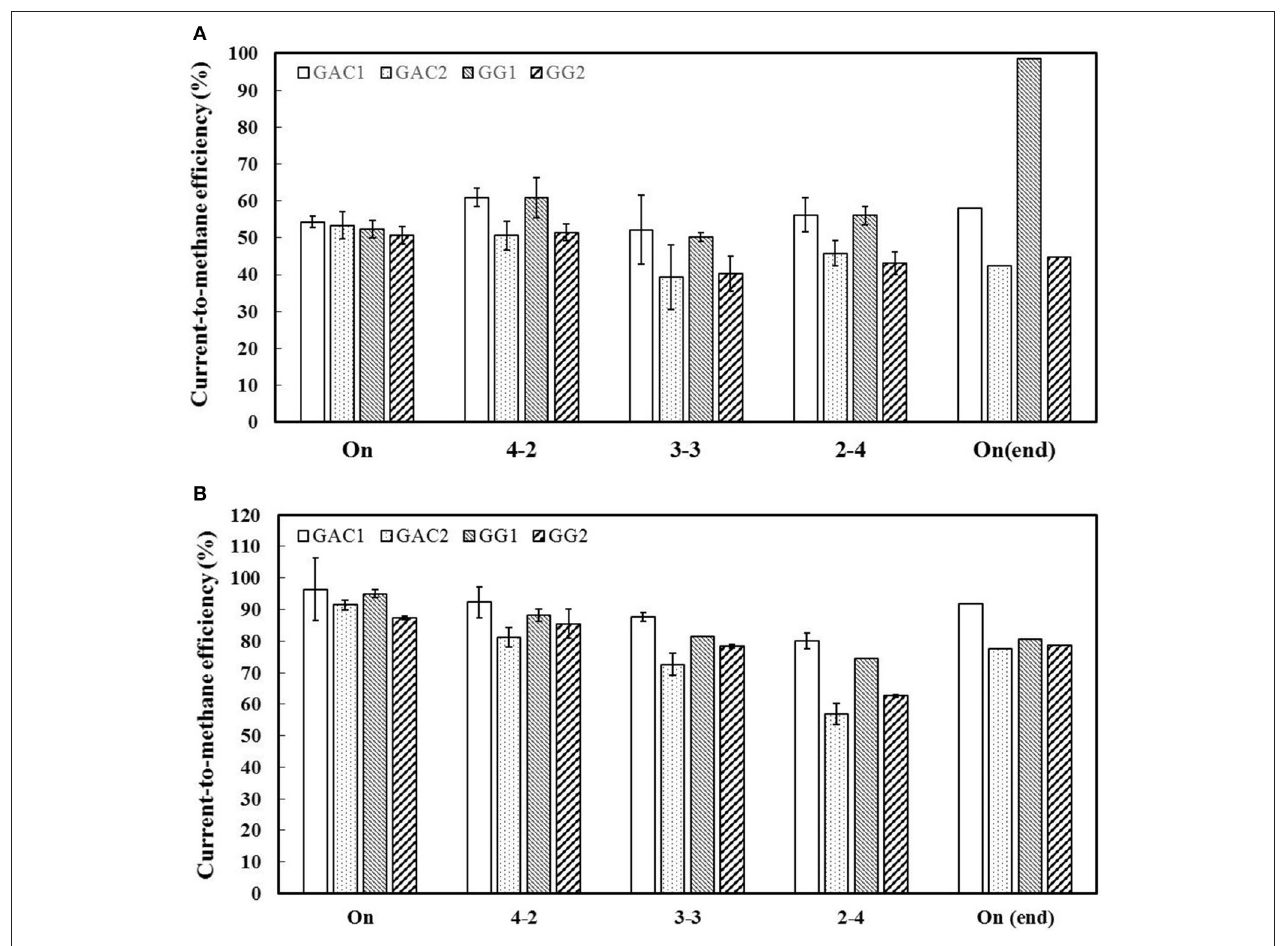
FIGURE 4 | Current-to-methane efficiencies (%) for all reactors when they were supplied with constant and intermittent current. Three different current time-ON/time-OFF ratios (4–2 ′ , 3–3 ′ and 2–4 ′ ) were carried out. The current density during the current time-ON was 10 A/m 2 cat proj (A) and 35 A/m 2 cat proj (B) . For each operational condition, duplicate operations were performed. The maximum and minimum values are shown as an error bar, whereas the average value is shown as a